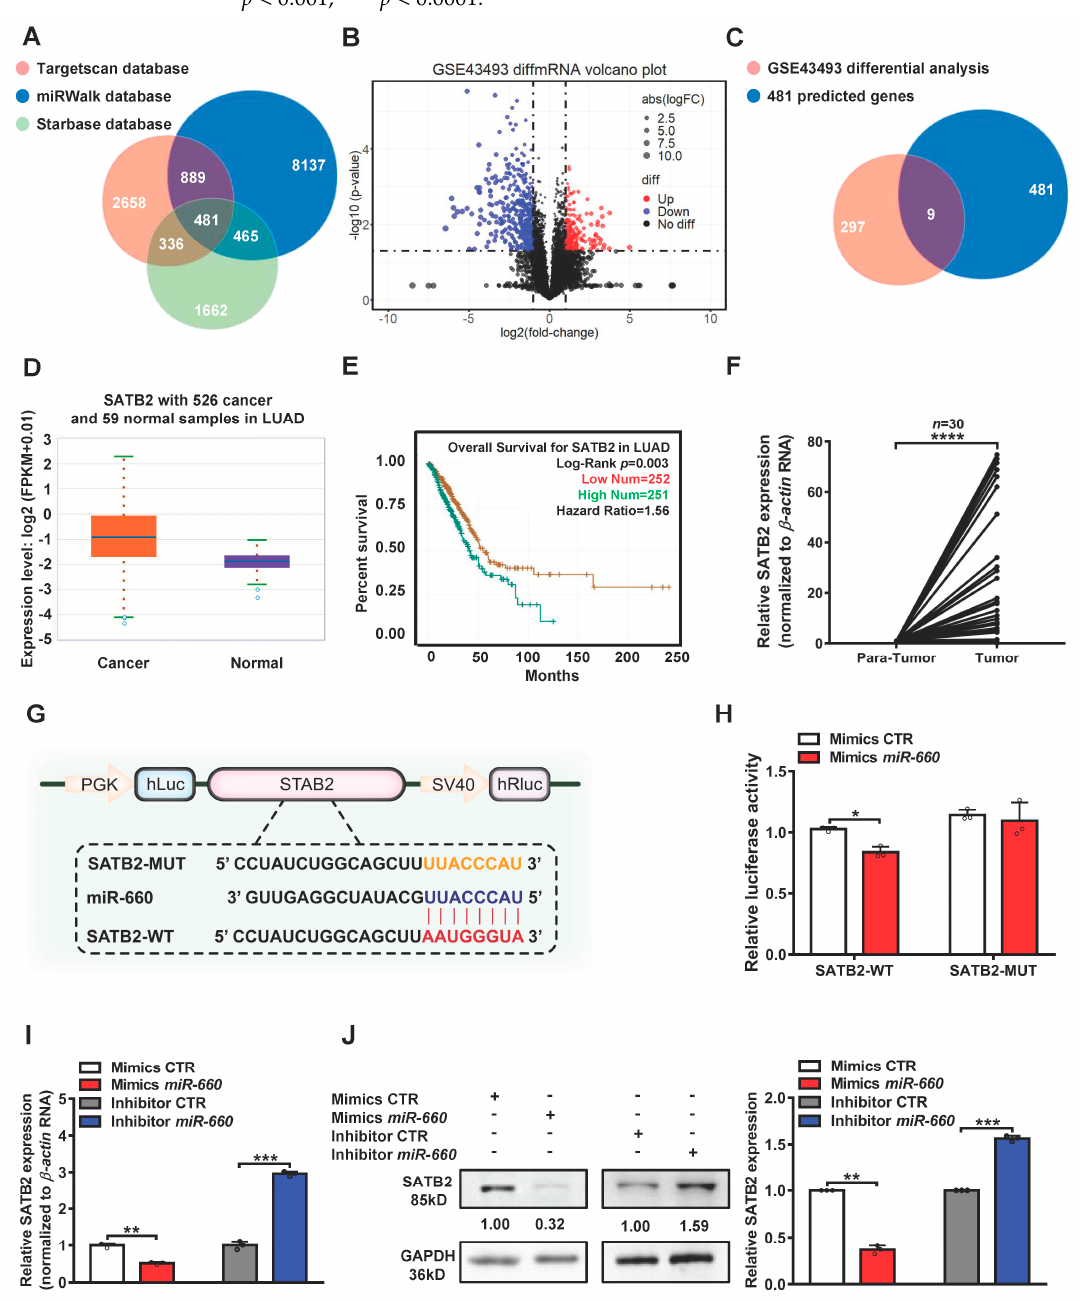
Figure 3. SATB2 is a direct target of miR - 660 . ( A ) Venn diagram of the results of three miRNA databases predicting miR - 660 target genes. ( B ) Volcano plot of the mRNA differential analysis using the GSE43493 dataset. ( C ) Venn diagram showing the intersection of 481 predicted target genes of miR - 660 and 297 upregulated genes in A549/CDDP cells. ( D , E ) The expression level of SATB2 in LUAD tissue and the relationship between SATB2 expression and prognosis of LUAD patients, according to the starbase database. ( F ) SATB2 expression in LUAD tissues and paired adjacent nontumorous tissues ( n = 30), measured by RT-qPCR. ( G ) Pattern diagram of the target sequences of miR - 660 and SATB2. ( H ) Double luciferase report assay to verify the binding of miR - 660 and SATB2. ( I , J ) The expression relationship between miR - 660 and SATB2 was determined by RT- qPCR and Western blot. Data are presented as mean ± standard deviation. * p < 0.05, ** p < 0.01, *** p < 0.001, **** p < 0.0001.